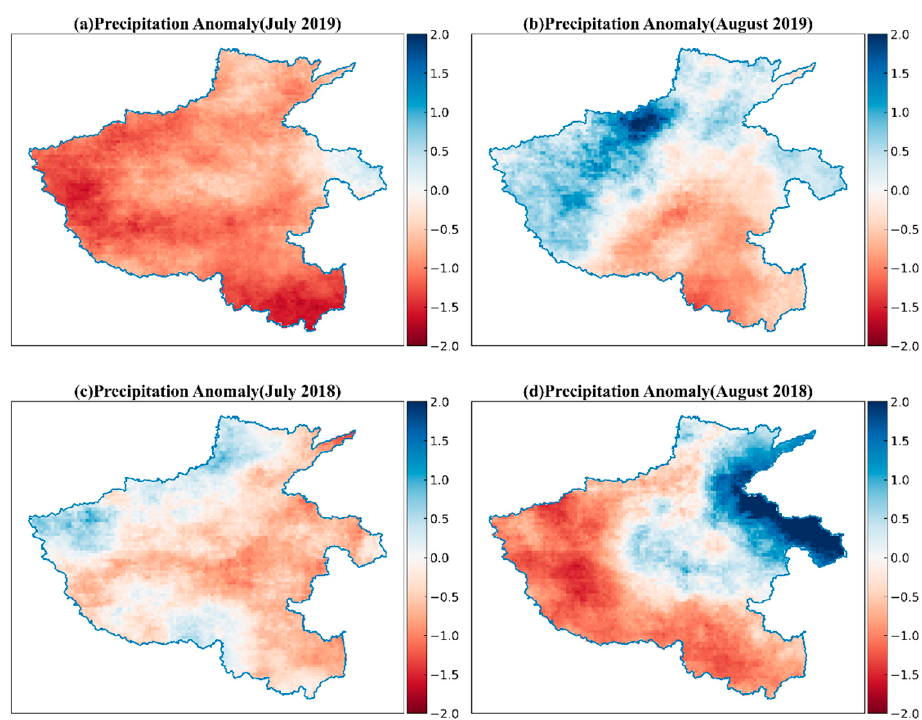
Figure 16. Spatial and temporal patterns of drought characterized by precipitation anomalies for July ( a , c ) and August ( b , d ) of 2018 and 2019.